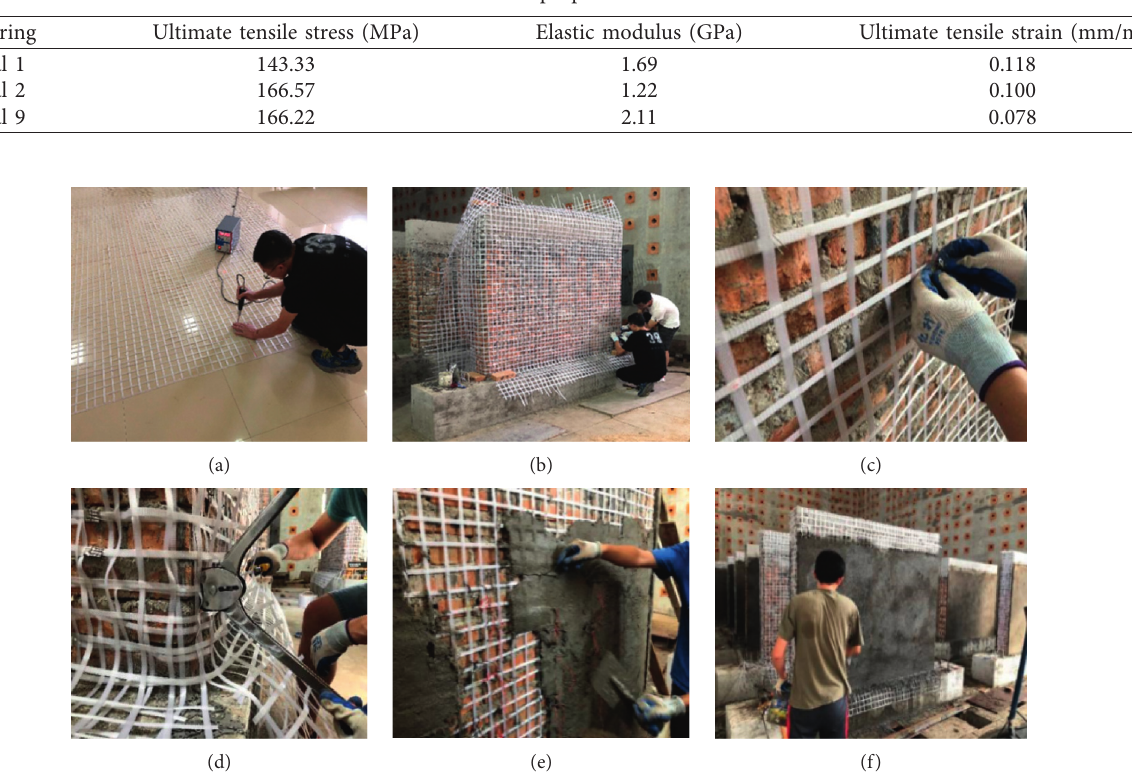
Figure 2: Stress-strain curve. Table 2: Mechanical properties of PP-bands.